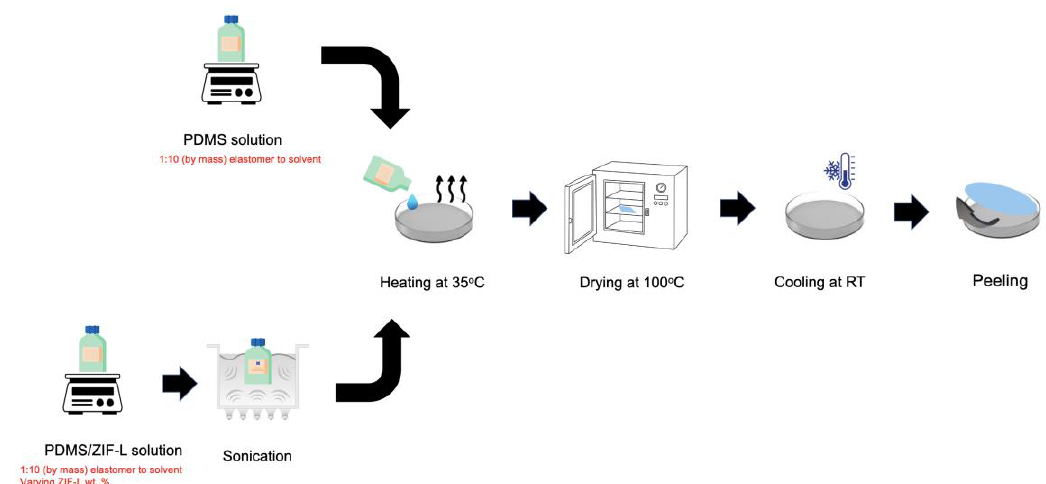
Figure 2. PDMS and ZIF-L@PDMS flat sheet membrane fabrication.